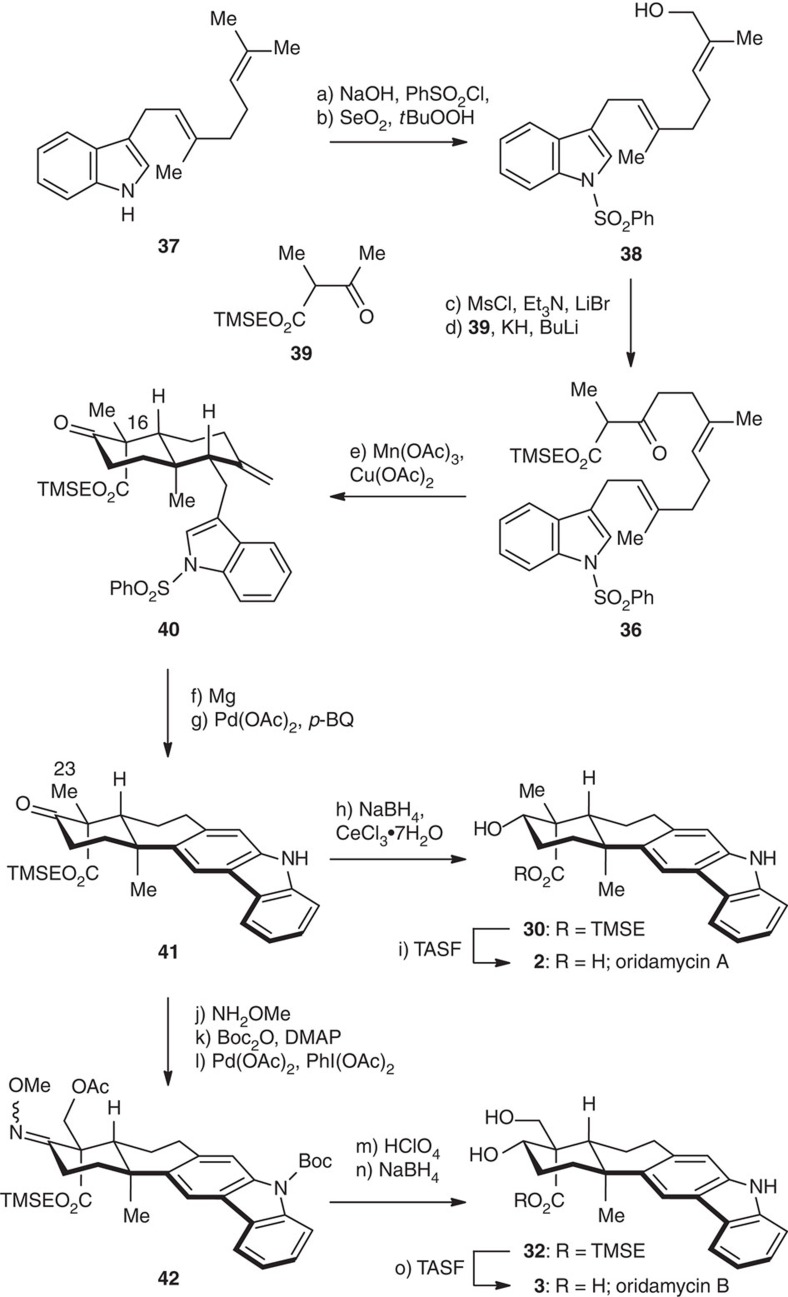
The oxidative Heck annulation approach towards the total syntheses of oridamycins A and B.Reagents and conditions: (a) PhSO2Cl (2.0 eq), Bu4NBr (10 mol%), aq. NaOH (50 wt%)/toluene (1:2), 22 °C, 3 h; (b) SeO2 (20 mol%), tBuOOH (2.0 eq), CH2Cl2, 0 °C, 10 h, 78% (two steps); (c) Et3N (1.5 eq), MsCl (1.2 eq), LiBr (5.0 eq), THF, 0 °C, 30 min; (d) 39, (1.0 eq), KH (1.2 eq), BuLi (1.2 eq), THF/HMPA (5:1), 0 °C, 3 h, 80% (two steps); (e) Mn(OAc)3·2H2O (2.0 eq), Cu(OAc)2·H2O (1.0 eq), DMSO, 22 °C, 12 h, 52%; (f) Mg (3.0 eq), NH4Cl (1.2 eq), MeOH, 22 °C, 1 h, 96%; (g) Pd(OAc)2 (20 mol%), p-benzoquinone (2.5 eq), AcOH/toluene (1:4), 50 °C, 2 h, 65%; (h) NaBH4 (3.0 eq), CeCl3·7H2O (3.0 eq), MeOH, 0 °C, 30 min; (i) TASF (2.0 eq), DMF, 50 °C, 2 h, 85% (two steps); (j) NH2OMe·HCl (2.0 eq), pyridine, 22 °C, 2 h, 93%; (k) Boc2O (2.0 eq), 4-DMAP (2.0 eq), THF, 22 °C, 1 h, 89%; (l) Pd(OAc)2 (20 mol%), PhI(OAc)2 (1.1 eq), Ac2O/AcOH (1:1), 110 °C, 1 h, 81%; (m) aq. HClO4 (6.0 M)/acetone (1:3), 22 °C, 8 h; (n) NaBH4 (3.0 eq), MeOH, 0 °C, 30 min, 54% (two steps); (o) TASF (2.0 eq), DMF, 50 °C, 2 h, 91%.